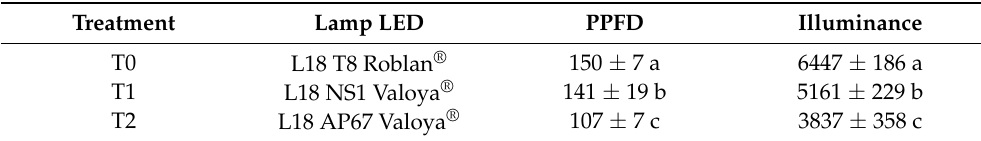
Table 1. Photosynthetic photon flux density (PPFD, μmol m −2 s −1 ) and illuminance (lux) of light emitting diode (LED) treatments.